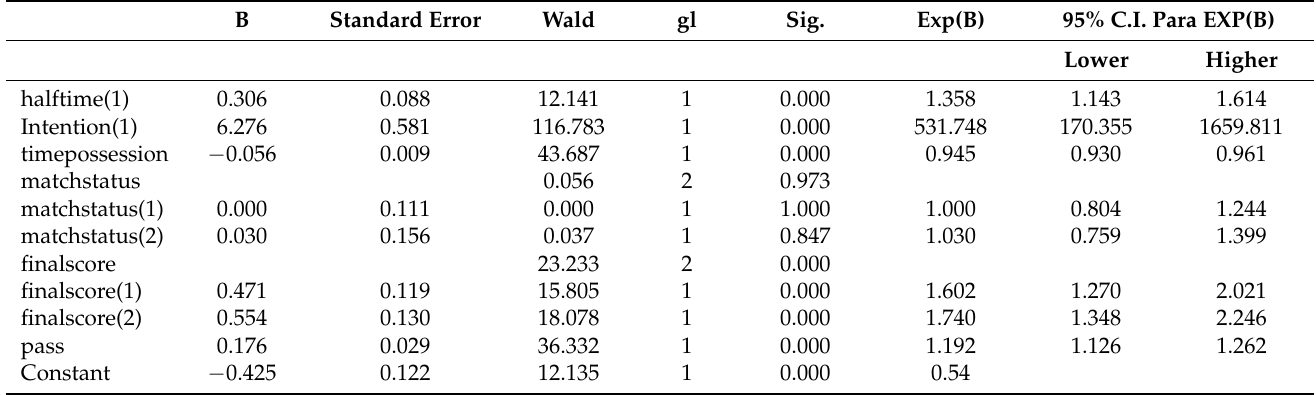
Table 3. Logistic regression